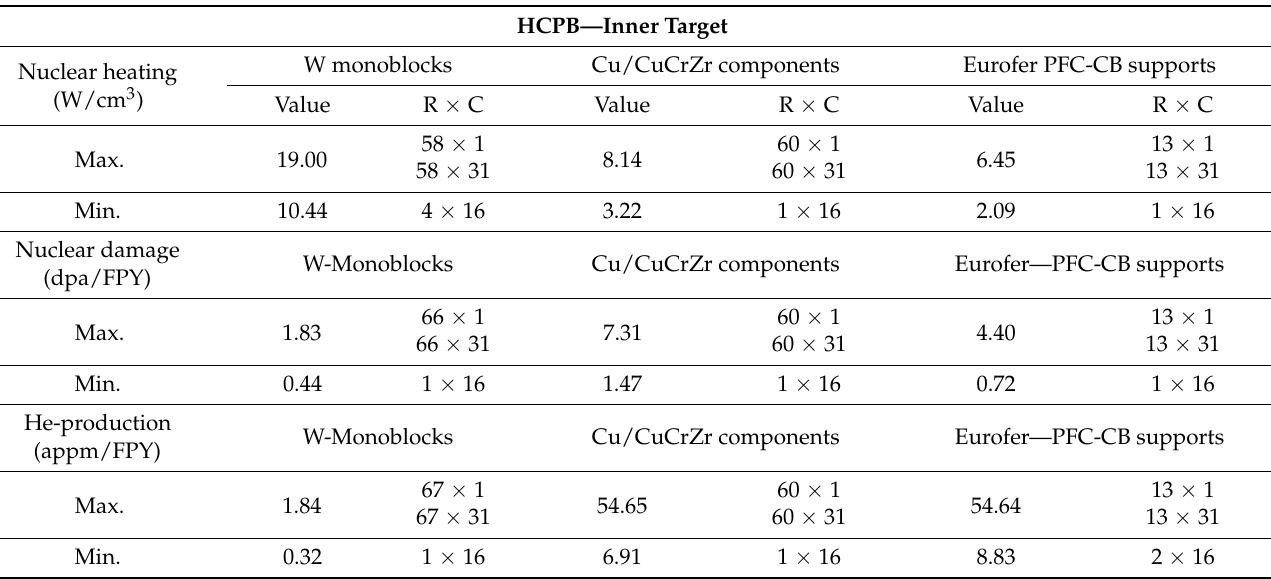
Table 8. Maximum and minimum values and related position (in terms of row (R) and column (C) of the array) of nuclear heating density (W/cm 3 ), nuclear damage (dpa/FPY), He-production (appm/FPY) on the PFCs of the HCPB inner target.